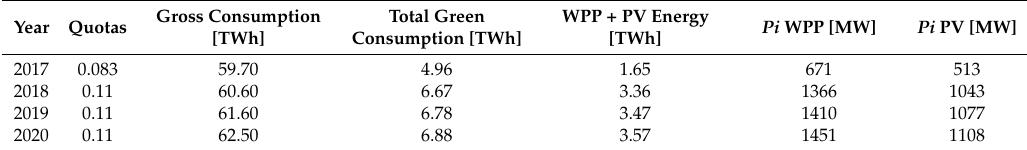
Table 6. Simulation of FLH variation scenario.